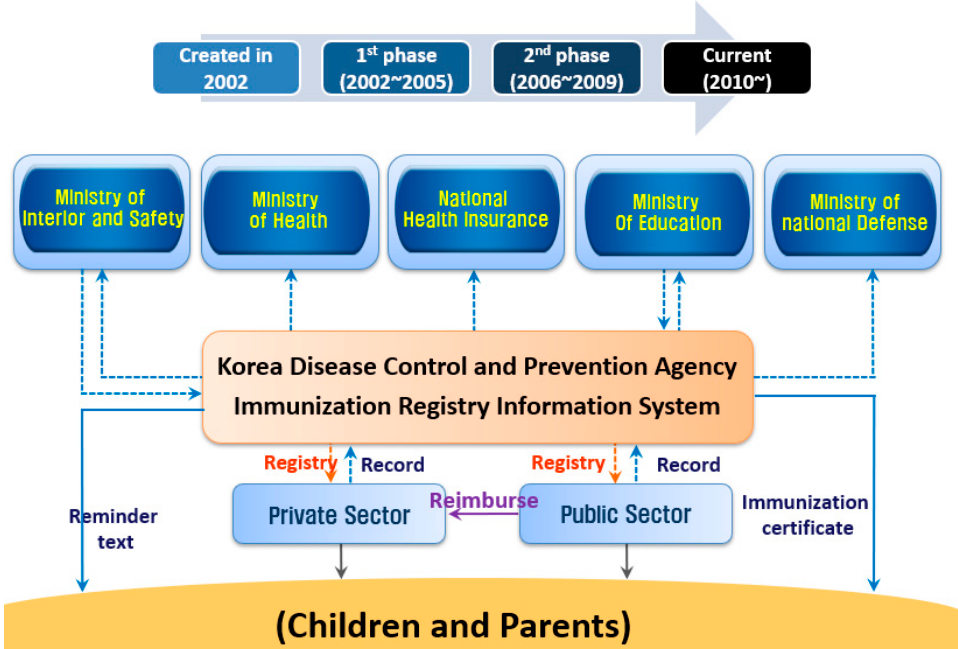
Figure 1. Scheme for Immunization Registry Information System (IRIS) in Korean National Immunization Program (NIP).